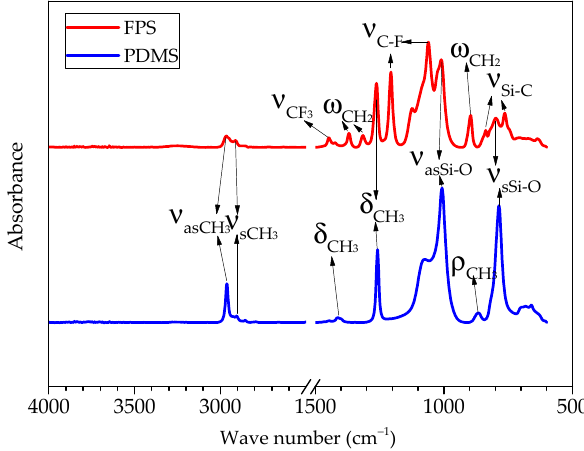
Figure 3. Infrared spectrum of studied coatings.